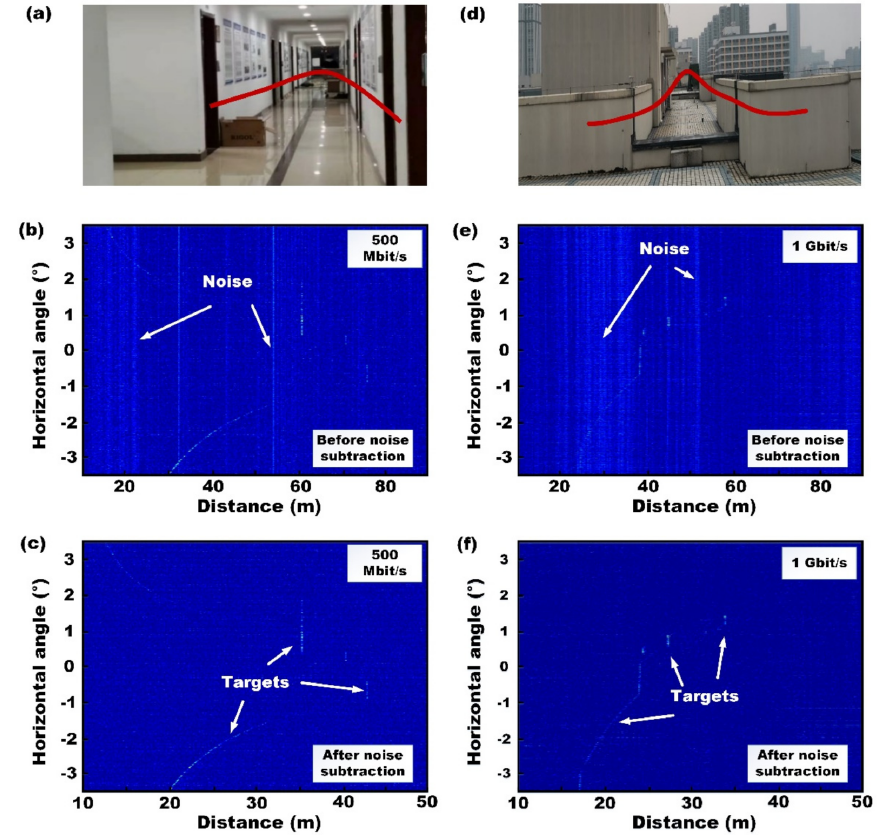
Figure 10. ( a ) Photographs of the corridor. ( b , c ) are the line-scanning measurement results for the corridor using a 500-Mbits/s M-sequence. ( d ) Photographs of the outdoor buildings. ( e , f ) Line- scanning measurements for the outdoor buildings using a 1-Gbits/s M-sequence. ( b , e ) is the results before noise subtraction, while ( c , f ) is the results after noise subtraction. The red lines in ( a , d ) indicate the scanning